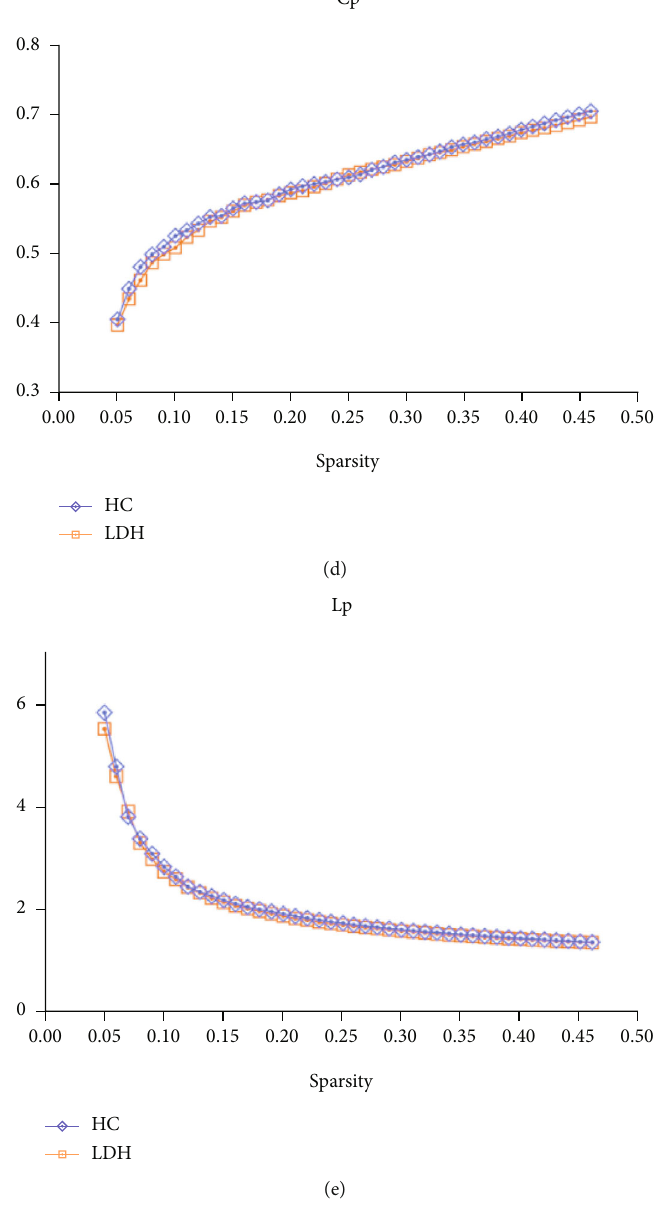
Figure 1: Changes of small-world parameters, clustering coe ffi cient (C induce nerve root compression patients and healthy controls as sparsity ranged from 0.1 to 0.46. No signi fi cant di ff erence was found between two groups in the normalized clustering coe ffi cients ( γ ) (a), normalized characteristic path length ( λ ) (b). small-worldness ( σ ) (C), clustering coe ffi cient (D) and characteristic path length (E) over a sparsity range of 0.1-0.46 (all p >